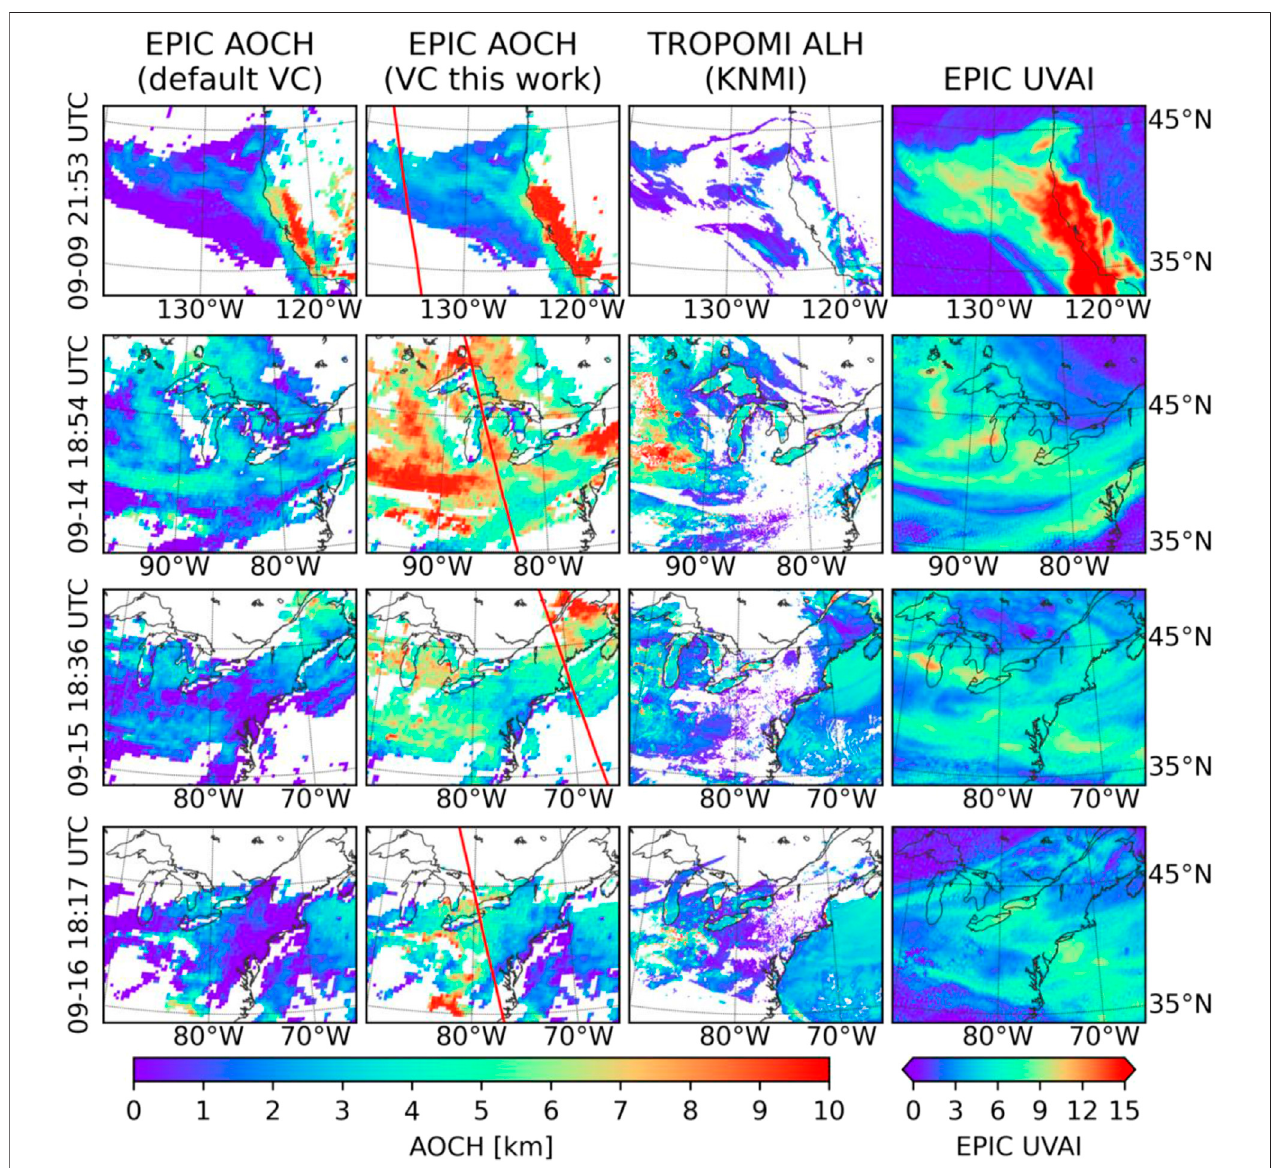
FIGURE 3 | Comparison of EPIC AOCH and TROPOMI operational ALH product for September 9 and 14 – 16. The fi rst and second columns are EPIC AOCH retrievals without and with vicarious calibration. The red lines in the second columns are the CALIOP sub-orbital tracks on each day. The third column is the TROPOMI operational ALH product from KNMI. The last column is the EPIC UVAI.